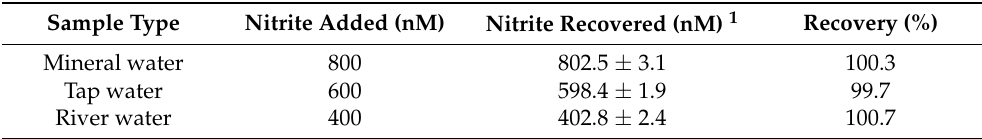
Table 2. Detection of nitrite in real water samples via Px-CuO NSs based